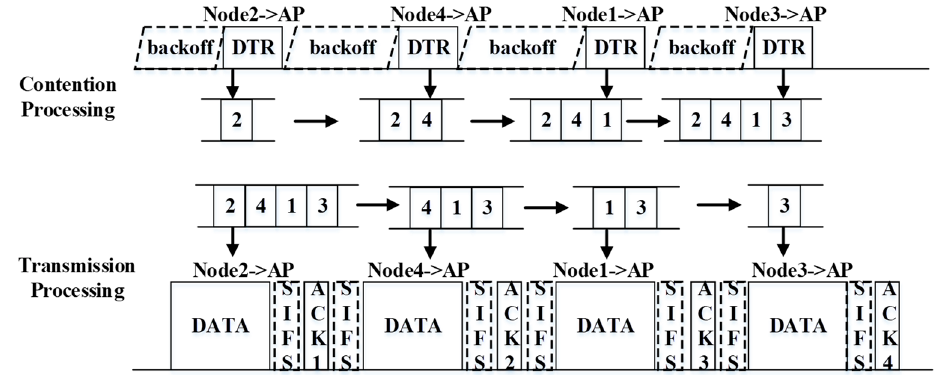
Figure 2. The procedure of basic decoupling Medium Access Control mechanism (DMAC).